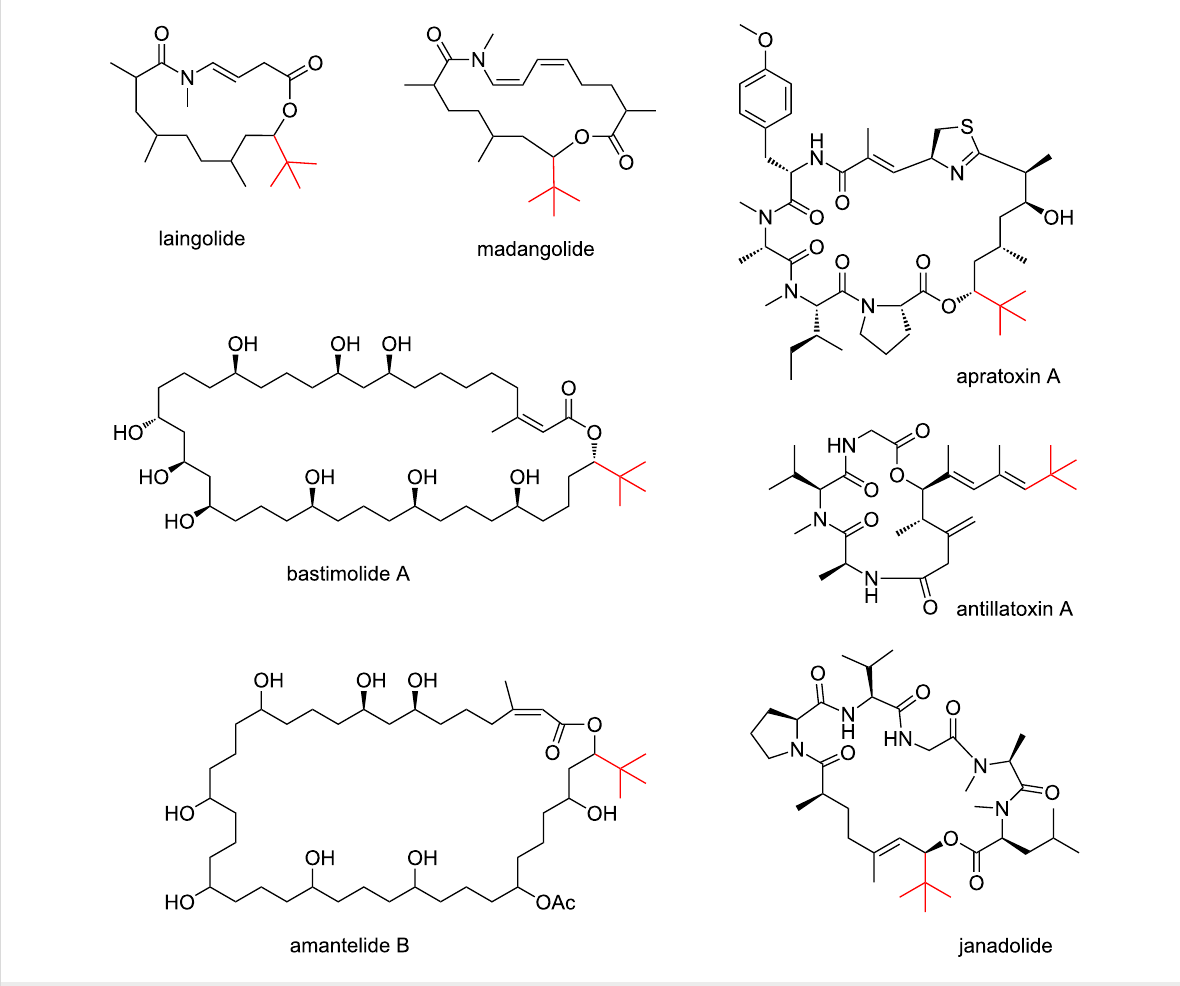
Figure 2: Cyanobacterial polyketides bearing a tert -butyl group.